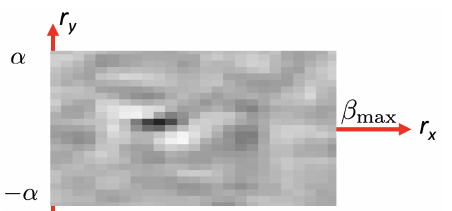
Figure 15. Error map for all rotations in the grid